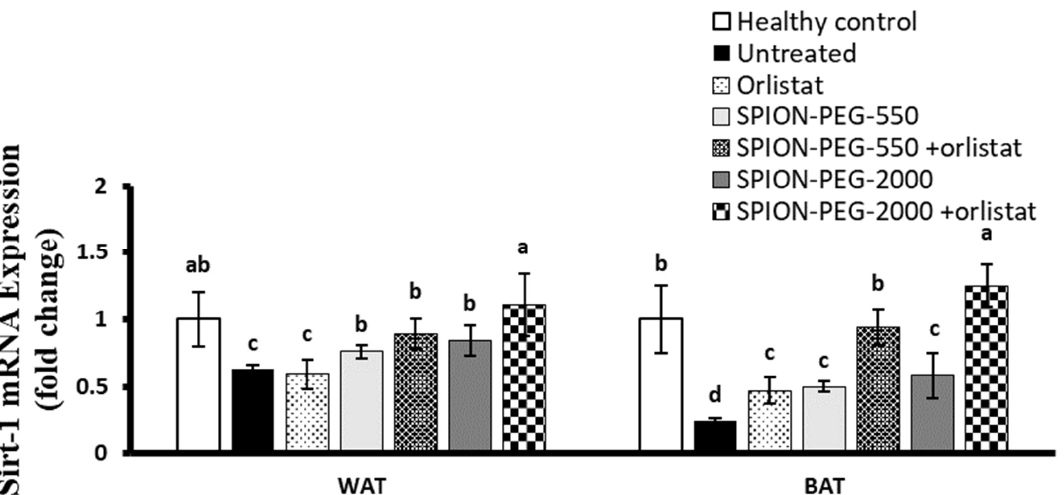
Figure 8. SIRT-1 expression in white and brown adipose tissues at mRNA level in control rats and obese rats untreated or treated with SPIONs and/or orlistat. Data presented as mean ± SD, and n = 8. Groups were compared at p < 0.05 using one-way ANOVA and Tukey post hoc test, and those which are not assigned with a shared letter (a–d) are statistically significant.